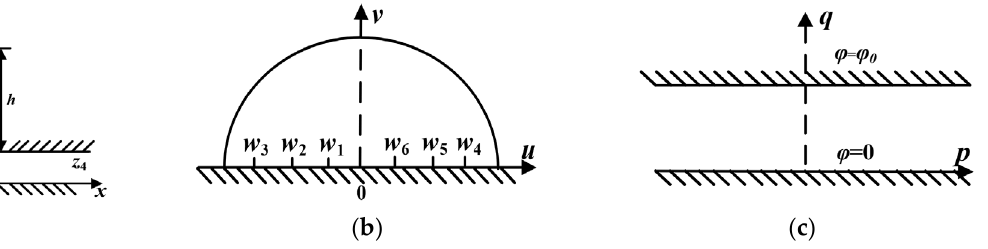
Figure 6. SCT analysis diagram of UP-LPST cogging effect. ( a ) z plane; ( b ) w plane; ( c ) t plane.